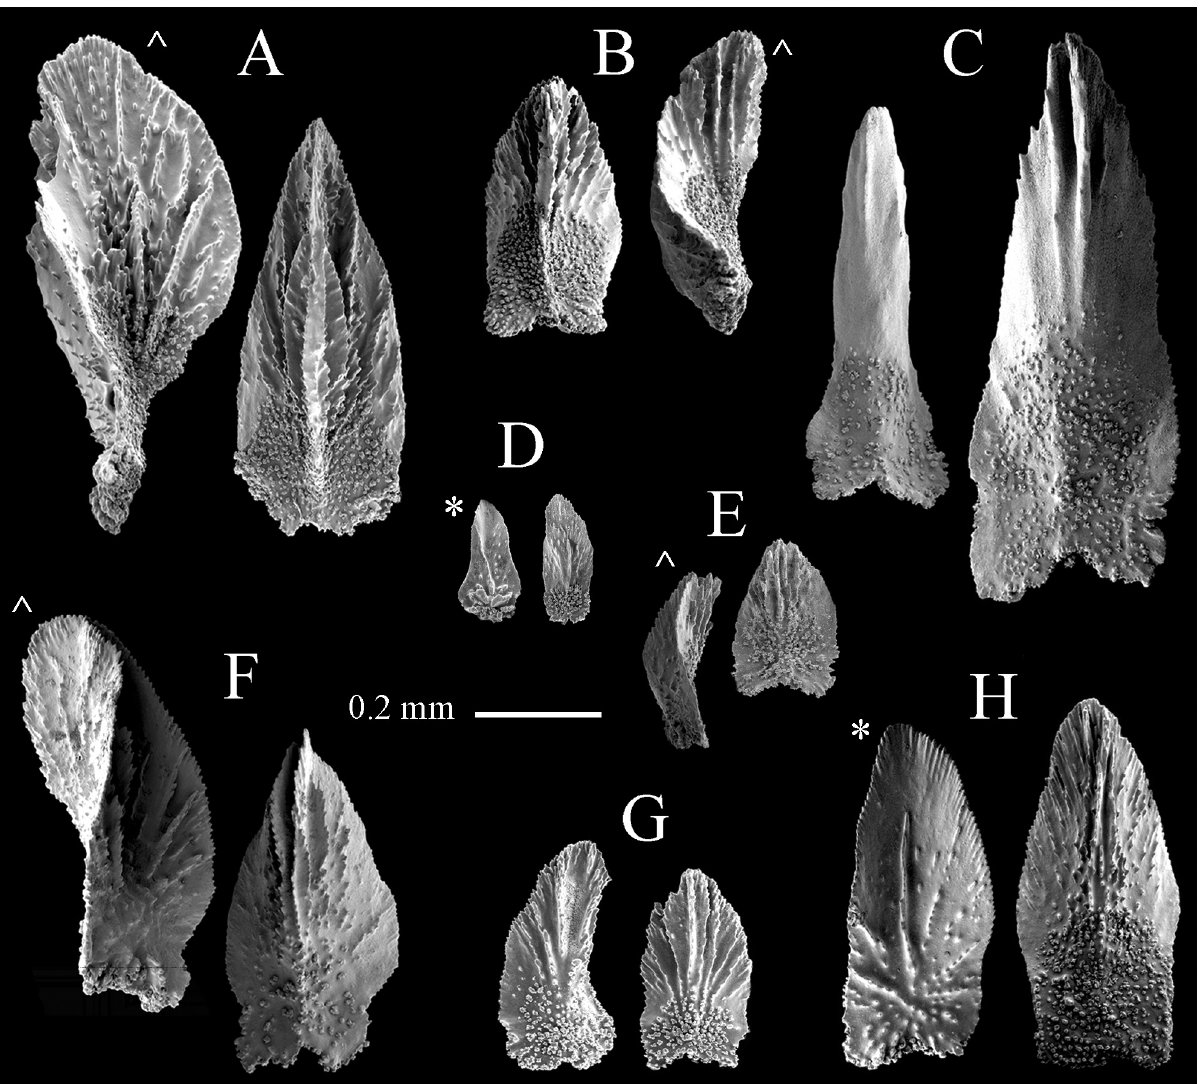
Fig . 18. – Comparison of opercular scales from species included in subgenus Epithouarella : A, Thouarella viridis Zapata-Guardiola and López-González, 2010, holotype (ZIZMH C11744); B, T. regularis (Wright and Studer, 1889), lectotype (BMNH 1889.5.27.60); C, T. dis- persa Kükenthal, 1912, holotype (ZMB Cni 5468); D, T. vitjaz sp.nov., type IORAS IV-9-Alc-010-002); E, T. crenelata Kükenthal, 1907, syntype (ZMB Cni 6081); F, T. grandiflora Kükenthal, 1912, holotype (MPUW 44); G, T. chilensis Kükenthal, 1908, type fragment (ZMB Cni 6079); H, T. affinis Wright and Studer, 1889, holotype (BMNH 1889.5.27.44). [*outer surface view; ^ lateral